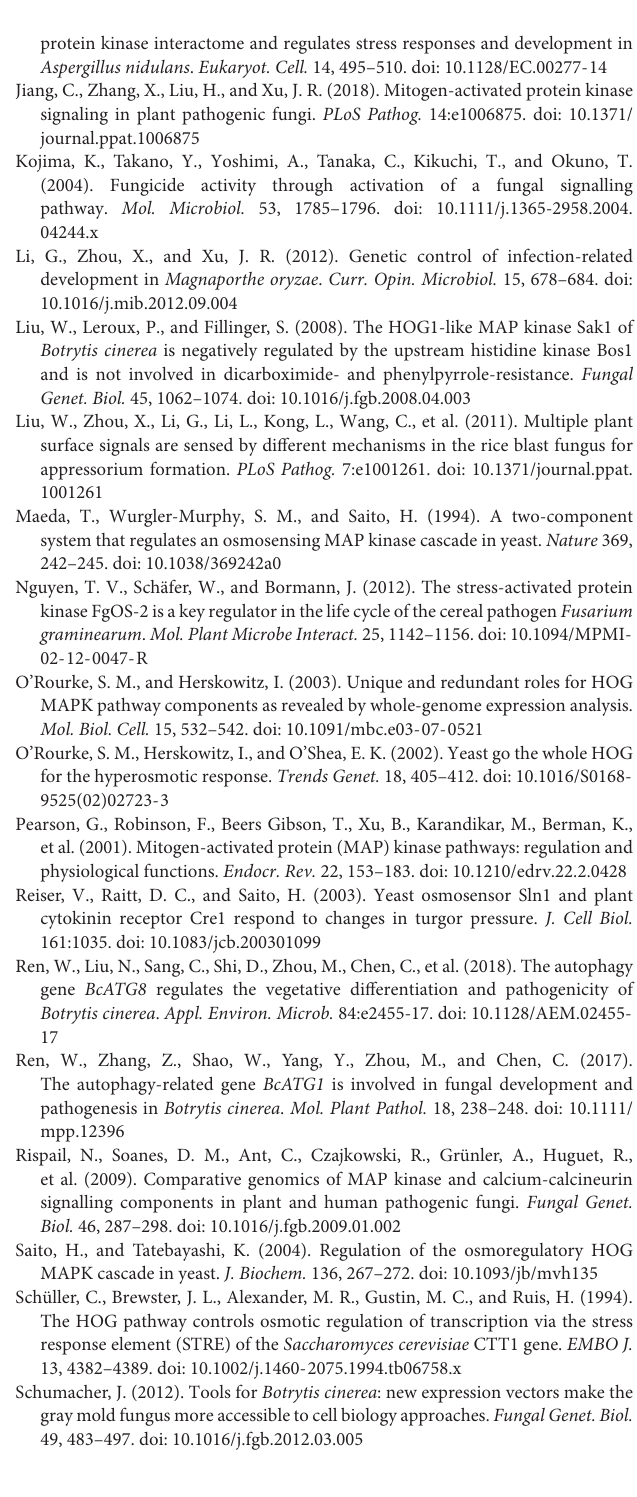
FIGURE S1 | Generation and identification of BcSHO1 and BcSLN1 deletion mutants. (A) Gene replacement strategy of BcSHO1 . (B) Southern blotting analysis of BcSHO1 mutant. (C) Gene replacement strategy of BcSLN1 . (D) Southern blotting analysis of BcSLN1 mutant. TABLE S1 | Oligonucleotide primers used in this